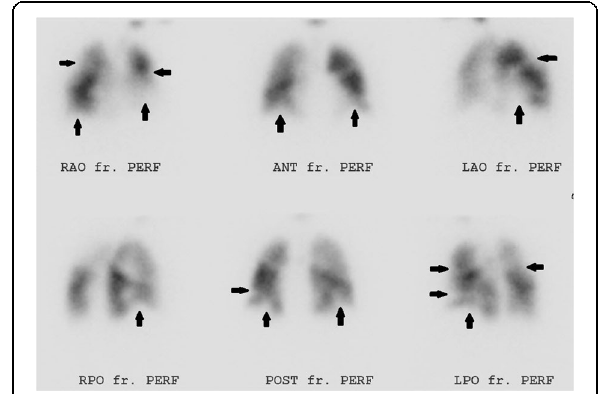
Fig. 18 Perfusion images of a V/Q scan in a patient with CTEPH. Multiple perfusion segmental defects in a patient with normal ventilation (arrows)